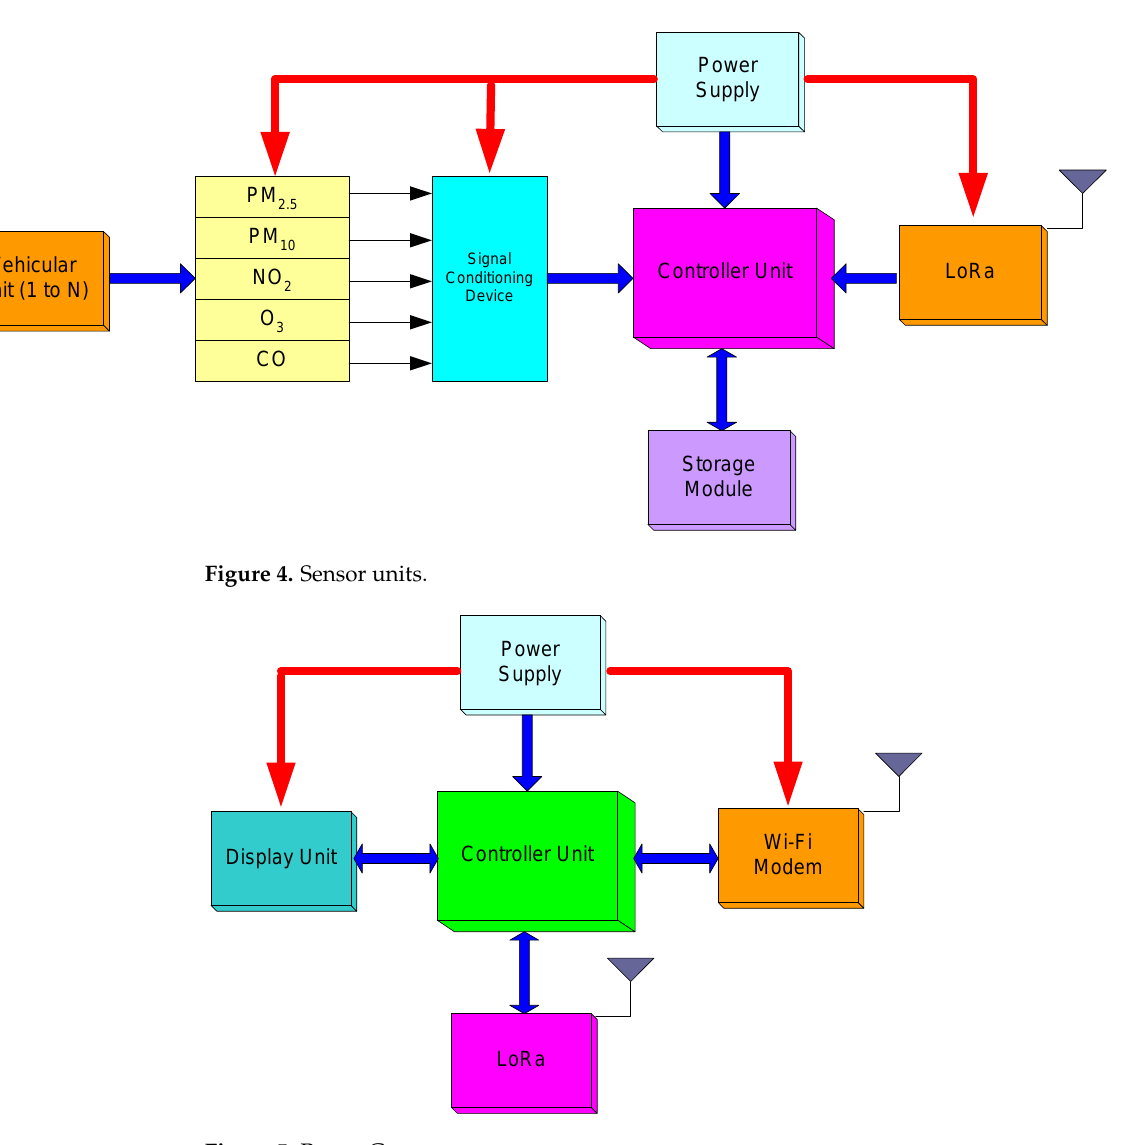
Figure 3. General architecture of the proposed system.